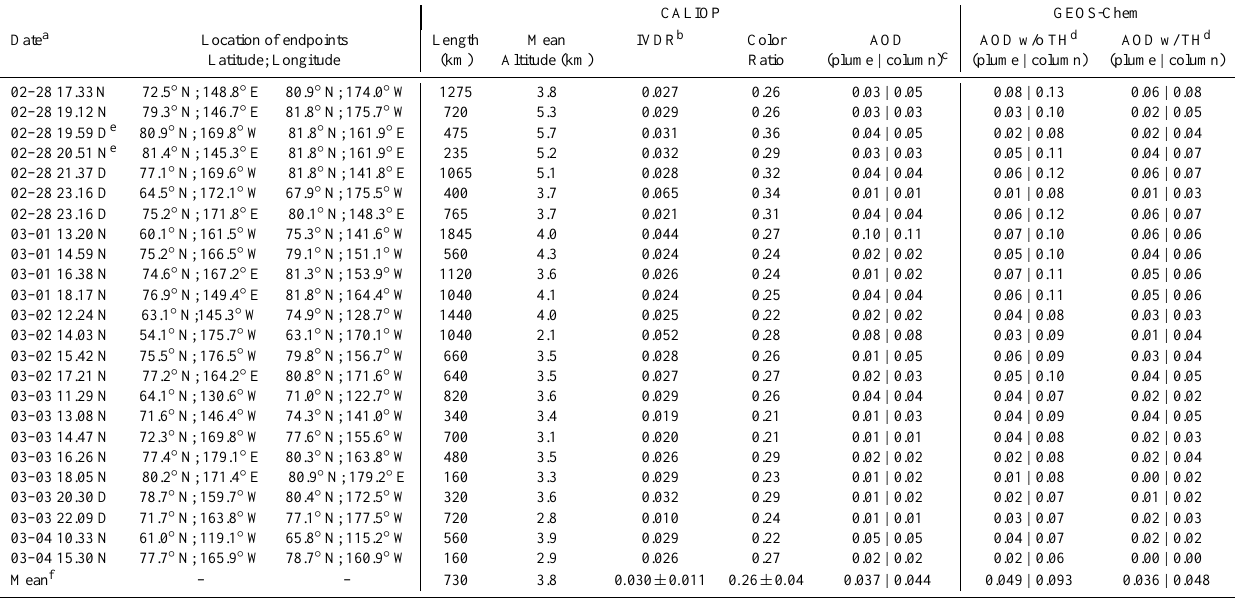
Table 1. Summary of the 23 Arctic aerosol layers observed by CALIOP for the 28 February–4 March 2007 case study. CALIOP